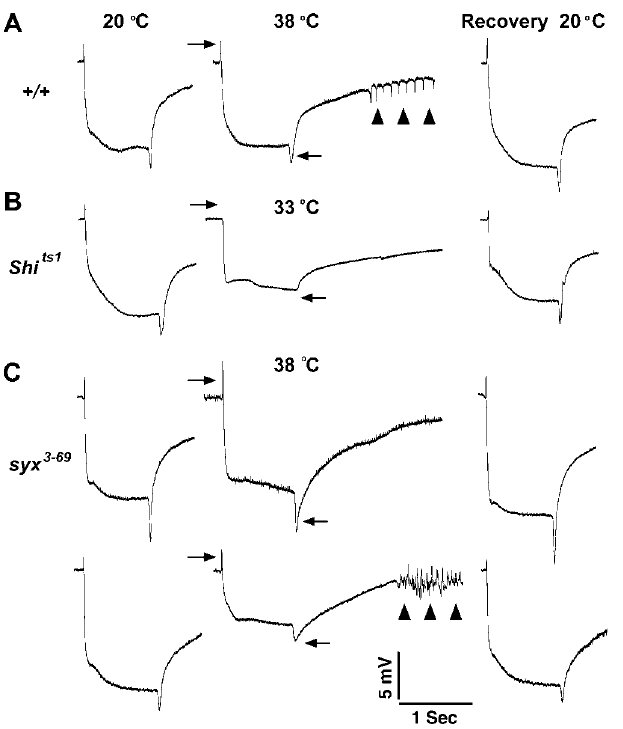
Figure 3. ERG Recordings Show That Synaptic Transmission Is Not Blocked in the syx 3–69 Mutant Fly at Restrictive Temperatures (A) ERGs are obtained from the wild-type fly at the permissive temperature (20 8 C), during the restrictive temperature (38 8 C), and during recovery at 20 8 C following a brief white-light stimulation of the compound eye. The spikes before and following the sustained photo- receptor potential are called ‘‘ on ’’ and ‘‘ off ’’ transient potentials (arrows), respectively. They are thought to reflect synaptic transmission from the photoreceptor to downstream interneurons. Note that these transient potentials are not significantly affected at 38 8 C. The extracellular recording electrode also detects light-induced high-frequency action potentials (arrowheads), which normally result in startle escape. (B) The ‘‘ on ’’ and ‘‘ off ’’ transient potentials are absent in Shi ts1 flies exposed at 33 8 C, consistent with a conditional block of vesicle recycling. (C) Under the same experimental conditions, the ‘‘ on ’’ and ‘‘ off ’’ transient potentials in the syx 3–69 mutant fly remain essentially similar to those observed in the wild-type fly. Even though the amplitude of photoreceptor potentials is reduced and the duration of recovery is prolonged, synaptic transmission is not blocked at 38 8 C in both the wild- type and the mutant fly. Additionally, the mutant fly also displays light- induced high-frequency action potentials (arrowheads), even though it is paralyzed.